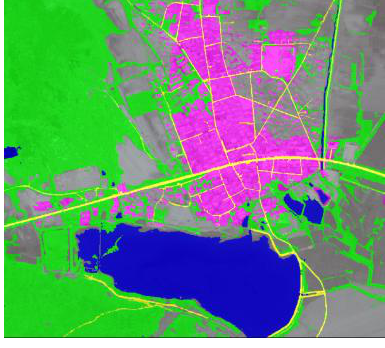
Figure 9. Results of information extraction